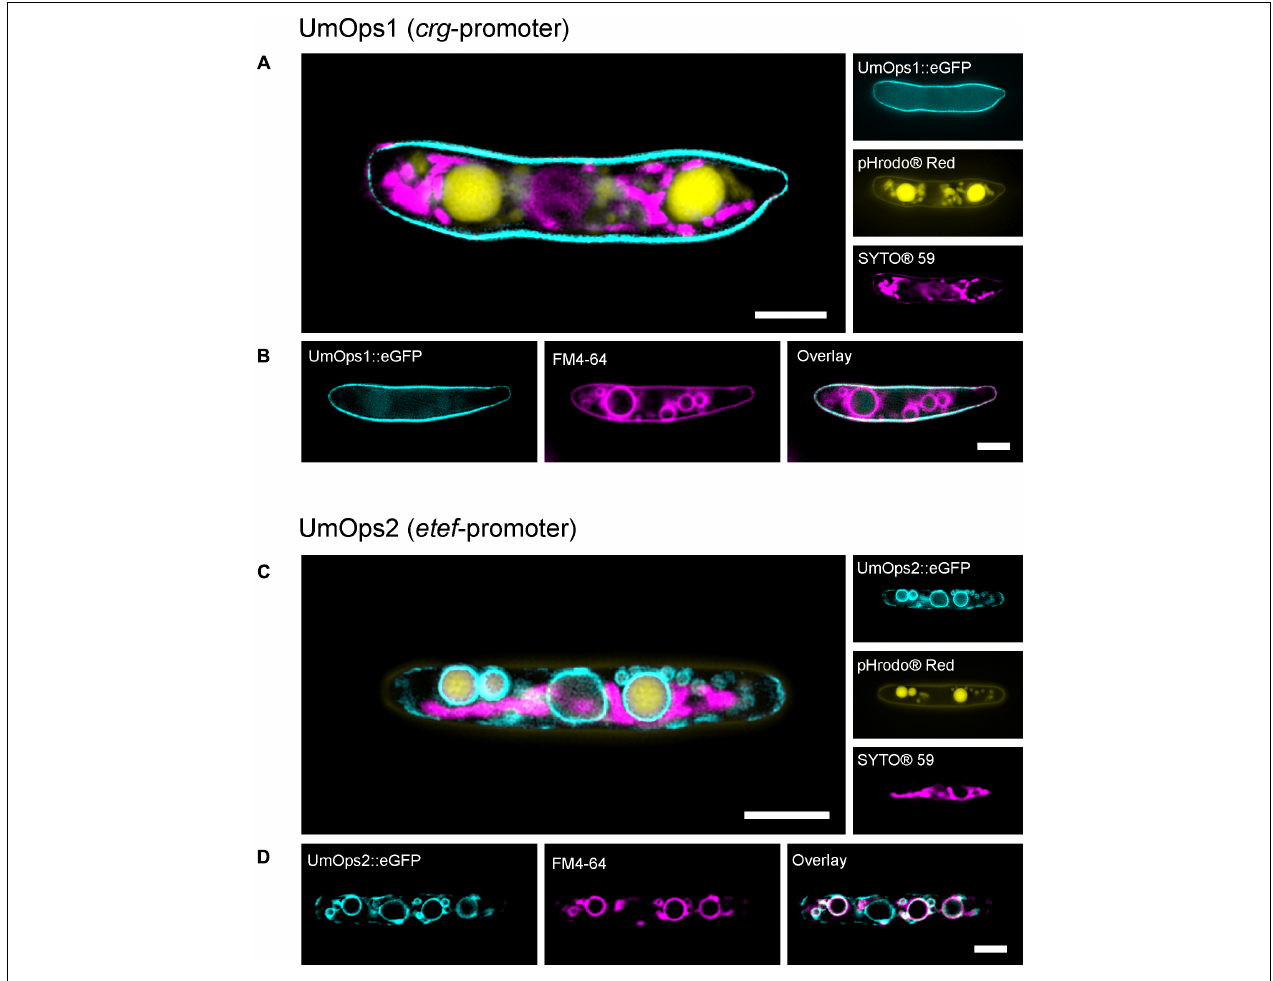
FIGURE 5 | Life-cell fluorescence microscopic analysis of the localization of eGFP-tagged UmOps1 (A,B) and UmOps2 (C,D) after heterologous expression in U. maydis sporidia. Images were obtained with a 3D-SIM. Sporidia were either co-stained for mitochondria (SYTO R (cid:13) 59) and vacuoles (pHrodo R (cid:13) Red; A,C ), or for vacuolar membranes (FM4-64; B,D ). Expression of UmOps1-eGFP was driven by the arabinose-inducible crg -promoter, expression of UmOps2-eGFP by the constitutive etef -promoter. Localization of UmOps2-eGFP after arabinose-induced expression is shown in Supplementary Figure S8 . Note that UmOps1 is mainly located in the plasma membrane whereas UmOps2 is present in the vacuolar membranes. Scale bars represent 3 µ